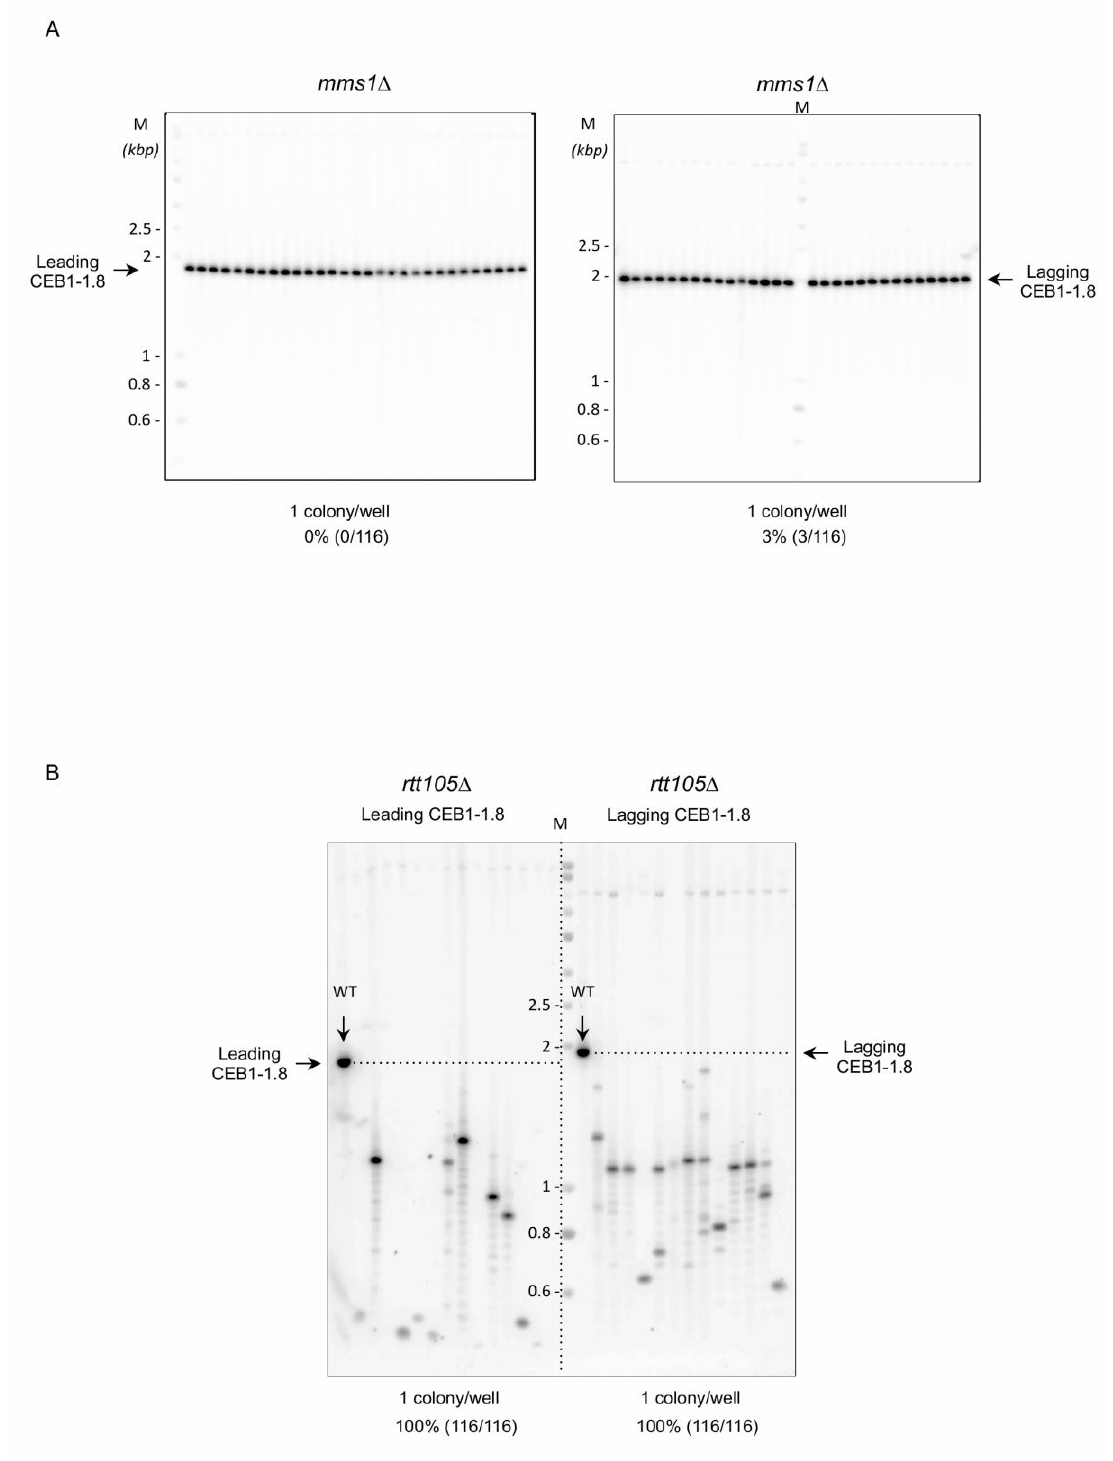
FIGURE 5: Importance of Mms1 and Rtt105 on CEB1 stability . (A) Mms1 is not required to stabilize CEB1. Left, genomic DNAs from mms1 ∆ yeast cells bearing the leading-CEB1 were digested by Apa I and Xho I and southern blotted. Right, genomic DNAs from mms1 ∆ yeast cells bearing the lag- ging-CEB1 were digested by Apa I and Nco I and southern blotted. Membranes were hybridized with the CEB1-0.6 probe. (B) Rtt105 is required to stabilize both leading-CEB1 and lagging-CEB1. Left, genomic DNAs from rtt105 ∆ yeast cells bearing the leading-CEB1 were digested by Apa I and Xho I and southern blotted. Right, genomic DNAs from rtt105 ∆ yeast cells bearing the lagging-CEB1 were digested by Apa I and Nco I and southern blotted. Membranes were hybridized with the CEB1-0.6 probe. WT: wild-type genomic DNA. The arrows show the position of stable leading-CEB1 (left) and stable lagging-CEB1 (right). The horizontal dashed lines indicate the theoretical position of stable CEB1. M: ladder DNA serving as size standard (kbp). The number of colonies analysed per well, the percentage of rearrangement frequencies, and the total numbers of colonies are indicated in Table